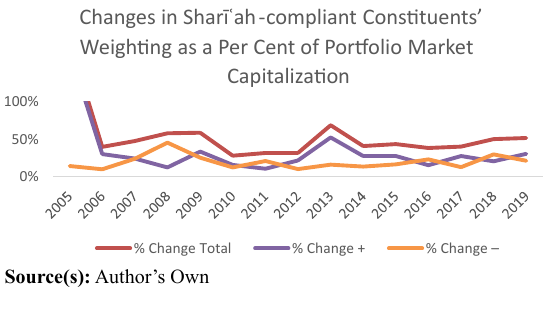
Figure 2. Changes in benchmark constituents ’ weighting as a percent of the total benchmark portfolio market capitalization as at the previous year